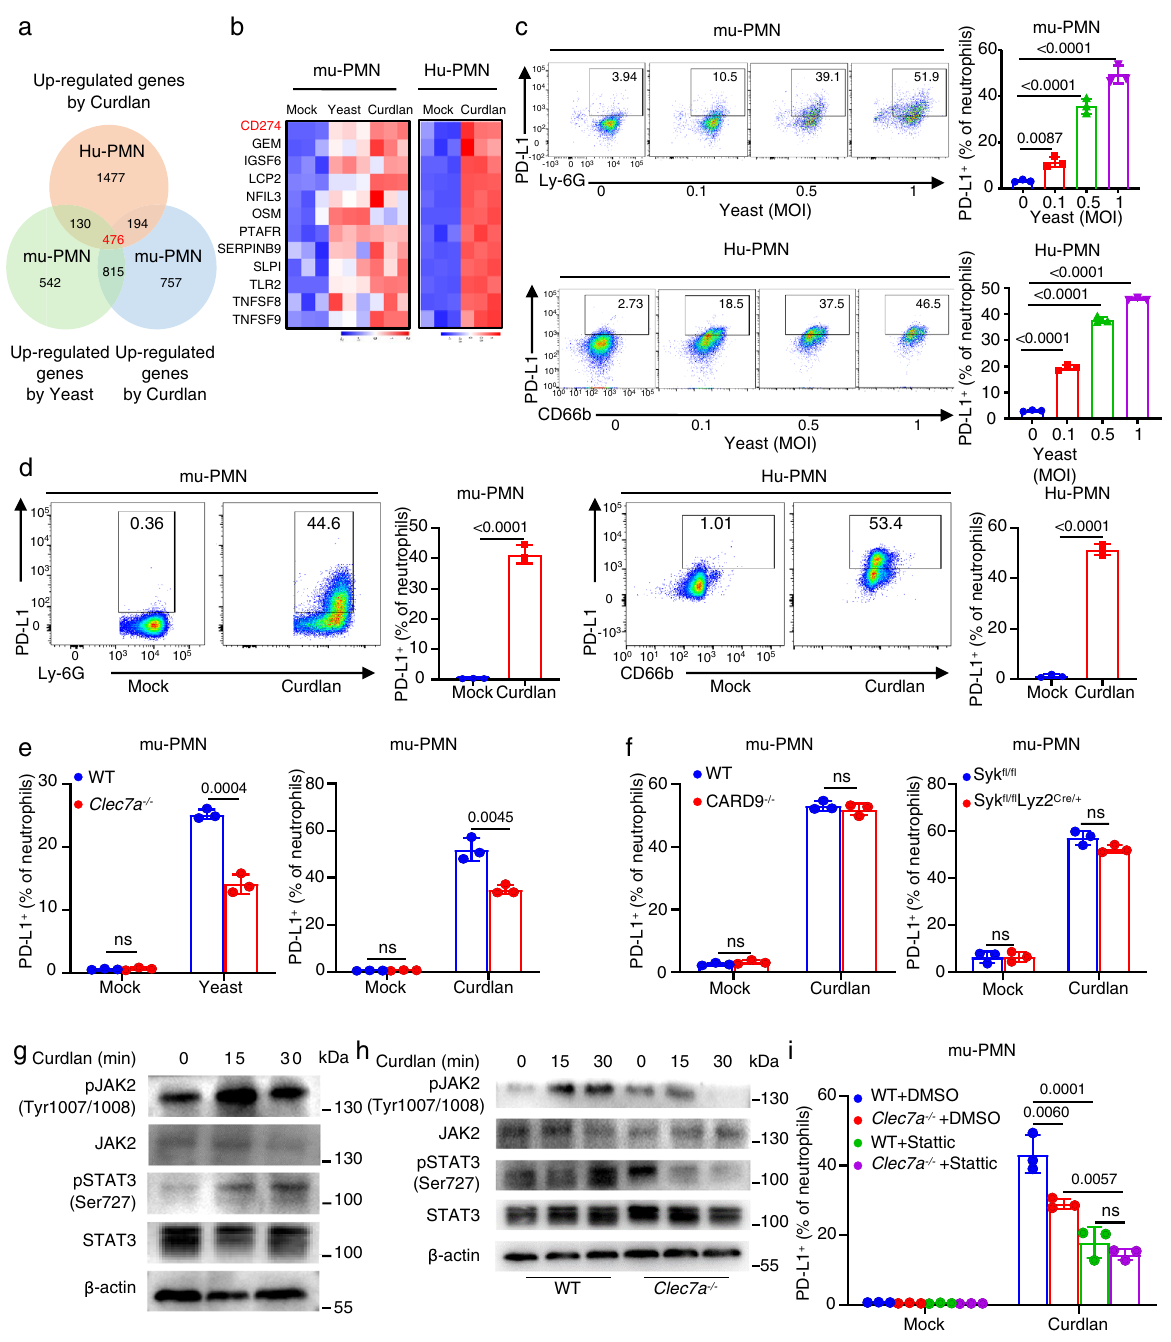
Fig. 1 | β -glucans from C. albicans activate the Dectin-1/JAK2/STAT3 axis to initiate PD-L1 expression in neutrophils. a , b RNA-seq analysis of bone marrow derived-neutrophils (mu-PMNs) and human neutrophils (Hu-PMNs), which were stimulated with curdlan (25 μ g/well for mu-PMNs and 50 μ g/well for Hu-PMNs) or heat-inactivated C. albicans yeast (MOI=0.1) for 4h. a Numbers of up-regulated genes as indicated. b Heatmaps of immune response-related genes of 476 co- upregulated genes as shown in a . c The percentage of PD-L1 + Ly-6G + mu-PMNs and PD-L1 + CD66b + Hu-PMNs after stimulation with heat-inactivated C. albicans yeast with indicated MOIs for 12h. d The percentage of PD-L1 + Ly-6G + mu-PMNs and PD- L1 + CD66b + Hu-PMNs after stimulation with curdlan (25 μ g/well for mu-PMNs and 50 μ g/well for Hu-PMNs) for 12h. e The percentage of PD-L1 + Ly-6G + mu-PMNs from wild-type and Clec7a − / − mice after stimulation with yeast (MOI=1) or curdlan